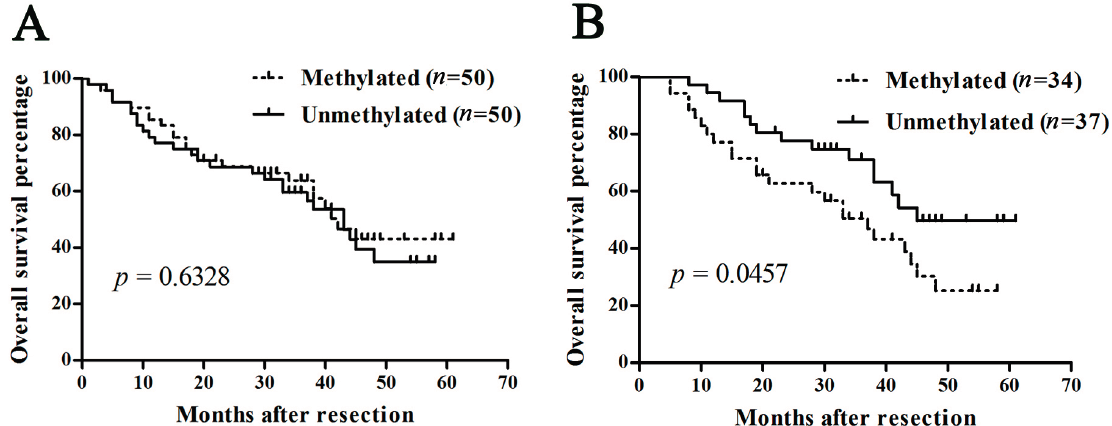
Figure 5. Kaplan–Meier survival plots for SOCS3 methylation in HCC patients. Overall survival after surgery according to SOCS3 methylation status in ( A ) general HCC patients and ( B ) HBV infection-related HCC